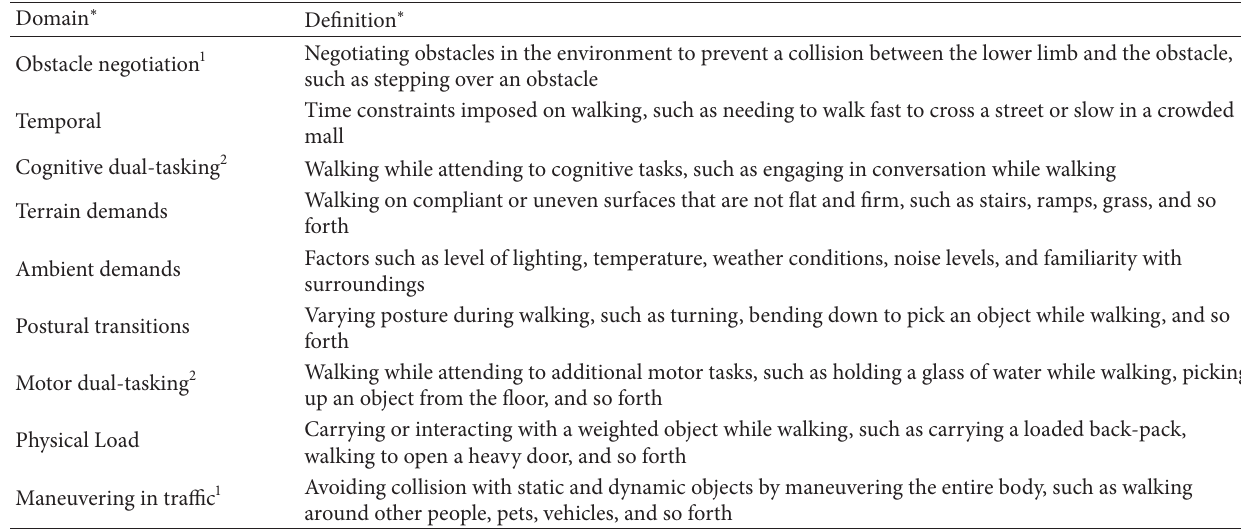
Table 1: Domains of walking